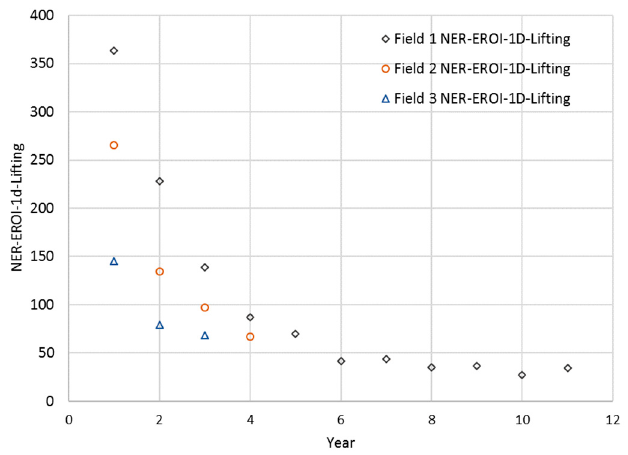
Figure 4. NER-EROI-1d Lifting time series for three small fields.